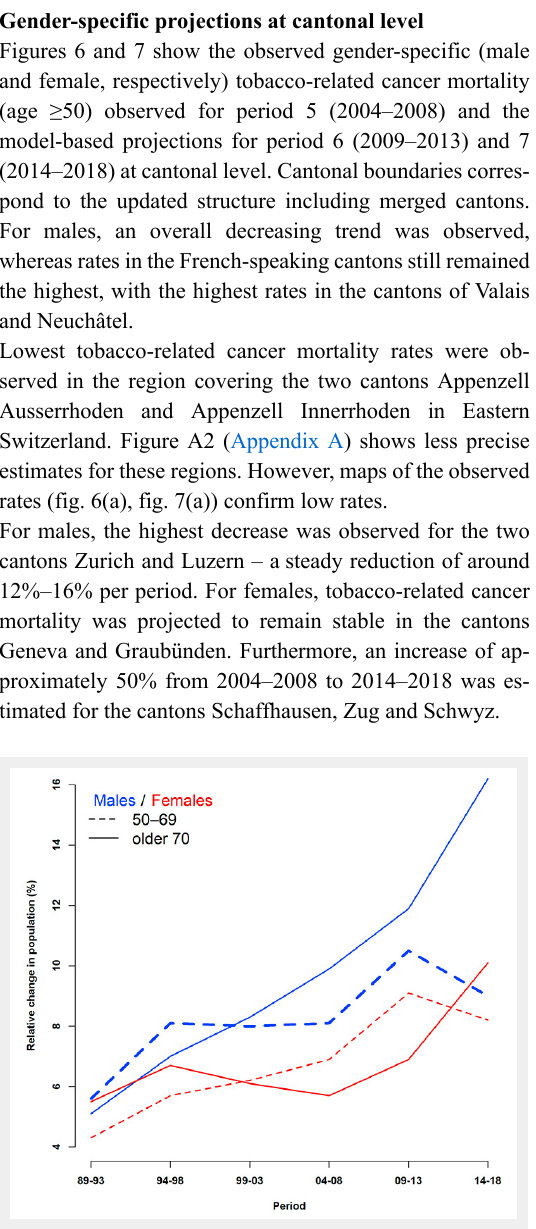
Language-region‒specific age-standardised tobacco-related cancer mortality rates (per 100,000), observed (during 1984–2008) and predicted (posterior median during 2009–2013 and 2014–2018) for (a) males and (b) females. The vertical line indicates the start of the prediction